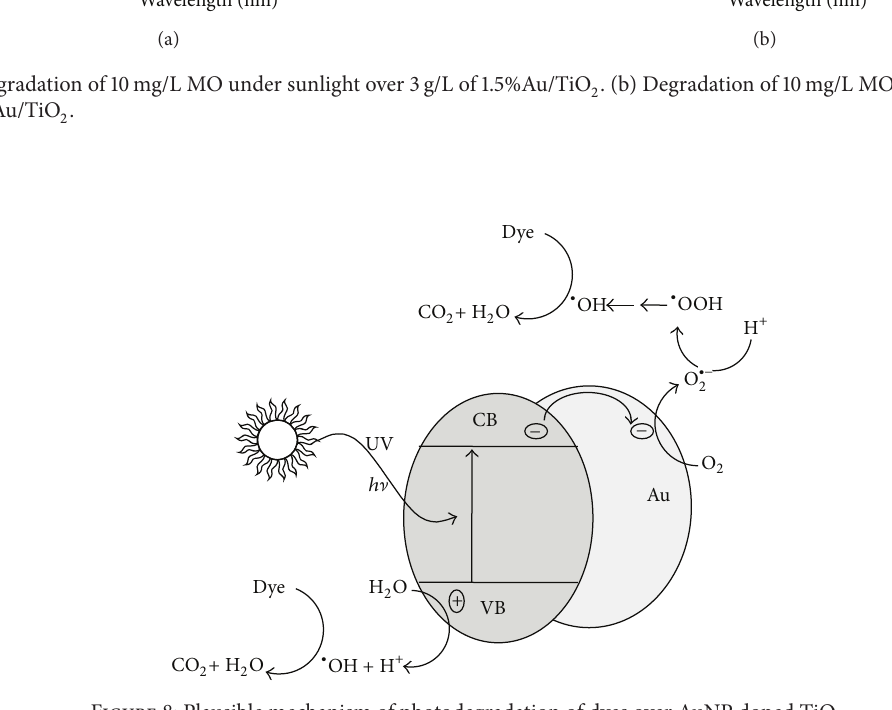
Figure 8: Plausible mechanism of photodegradation of dyes over AuNP doped TiO 2